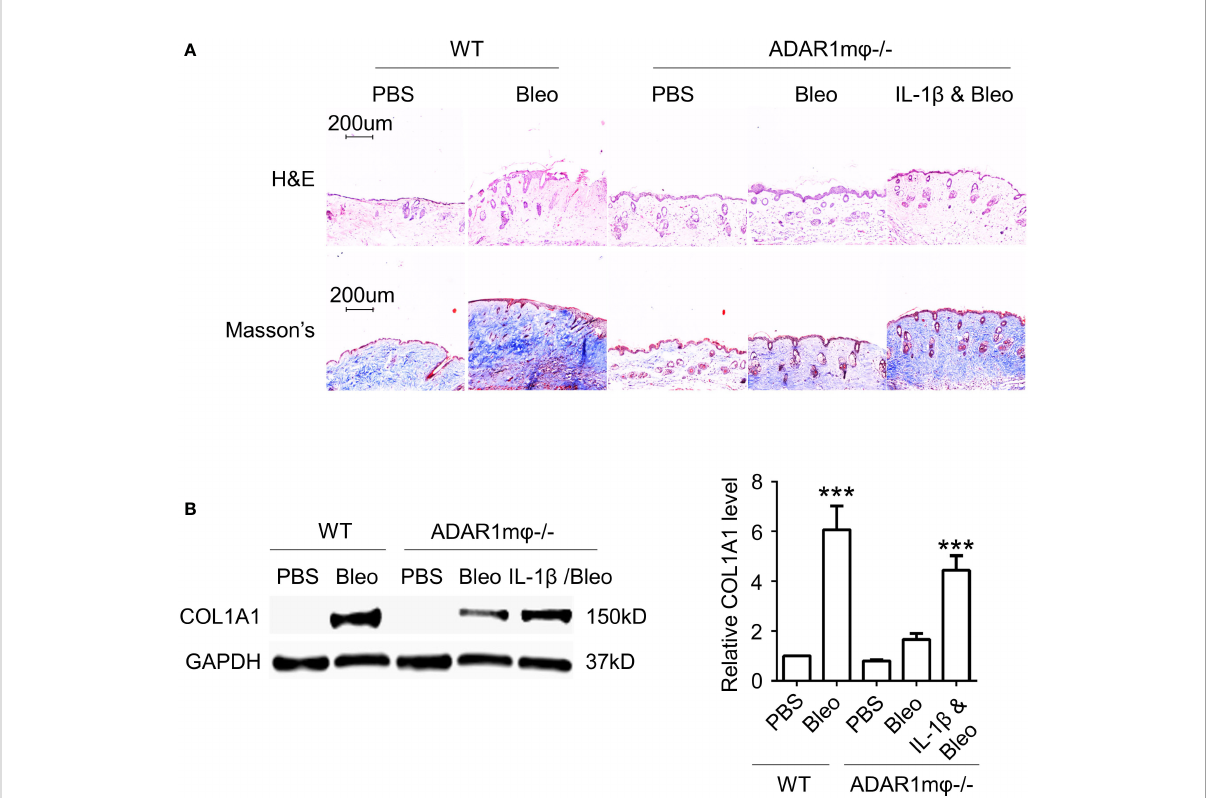
FIGURE 6 IL-1 b is required for ADAR1 mediated SSc. Mice were injected s.c. IL-1 b into ADAR1m j -/- mice followed by vehicle (PBS) or bleomycin (Bleo) treatment, and skin tissues were collected 28d after the treatment. (A) IL-1 b deteriorated the ADAR1m j -/- induced skin fi brosis relief, as shown by Masson ’ s trichrome staining. H&E staining showed skin structure. 20x power of objective lens was used to acquire images. (B) IL-1 b exacerbated the ADAR1m j -/- blocked COL1A1 expression in skin tissues, as determined by Western blotting. Col1a1 protein levels were quanti fi ed by normalizing to GAPDH. ***P < 0.001, n = 3. 2-way ANOVA was used for comparison among